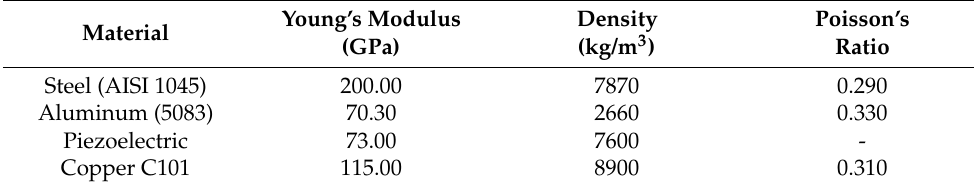
Table 2. Material properties of the vibratory device components.